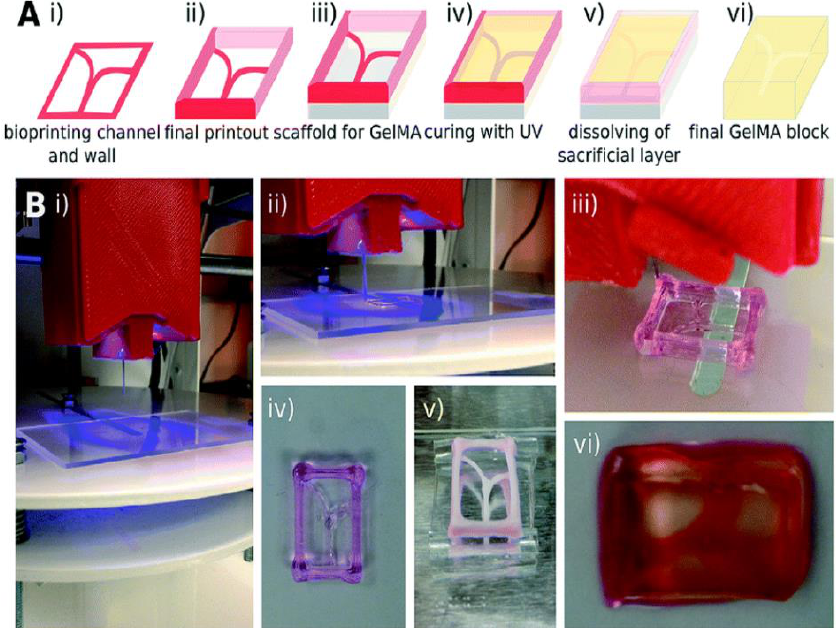
Figure 13. ( A ) Schematic of the bioprinting process: ( i , ii ) bioprinting the Pluronic template; ( iii ) dried out the bioprinted template on a PDMS support; ( iv ) filled with GelMA inside the channel and cured with UV cross-linking; ( v ) dissolution of the sacrificial channels and frame; ( vi ) the final construct with hollow channels coated with GelMA. ( B ) Photographs showing the experimental steps corresponding to the sacrificial bioprinting process illustrated in ( A ). Adapted from Zhang et al [7].